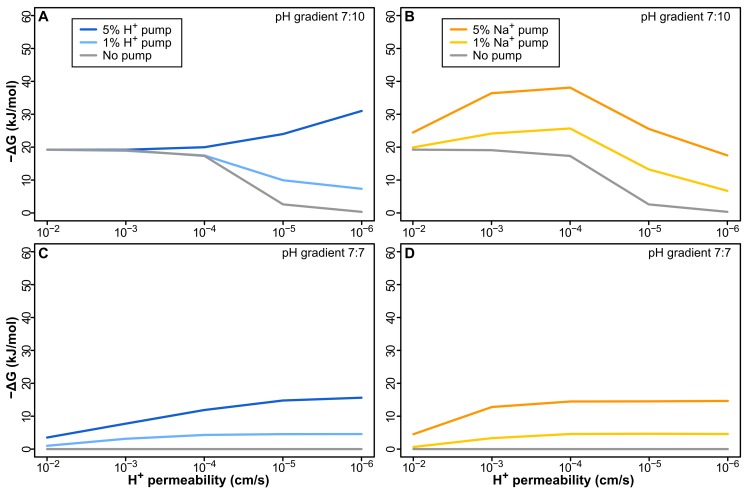
Pumping H+ or Na+ does not offer a sustained selective advantage.(A) Pumping H+ in a membrane with 1% ATPase causes a sustained loss in −ΔG as membrane permeability decreases with 1% pump. Even with 5% pump, −ΔG does not change over 3 orders of magnitude, and pumping only improves −ΔG near modern membrane permeability (≤10−5 cm/s). (B) Pumping less-permeable Na+ is initially better, adding to the natural gradient, but the early benefit is lost as membranes become tighter, due to the collapse of the natural H+ gradient. In the absence of a gradient, pumping both H+ (C) and Na+ (D) offers a sustained advantage to tightening up membranes, but given a minimal requirement of around 15–20 kJ/mol to power aminoacyl adenylation, the energy attained is not sufficient to power intermediary biochemistry.